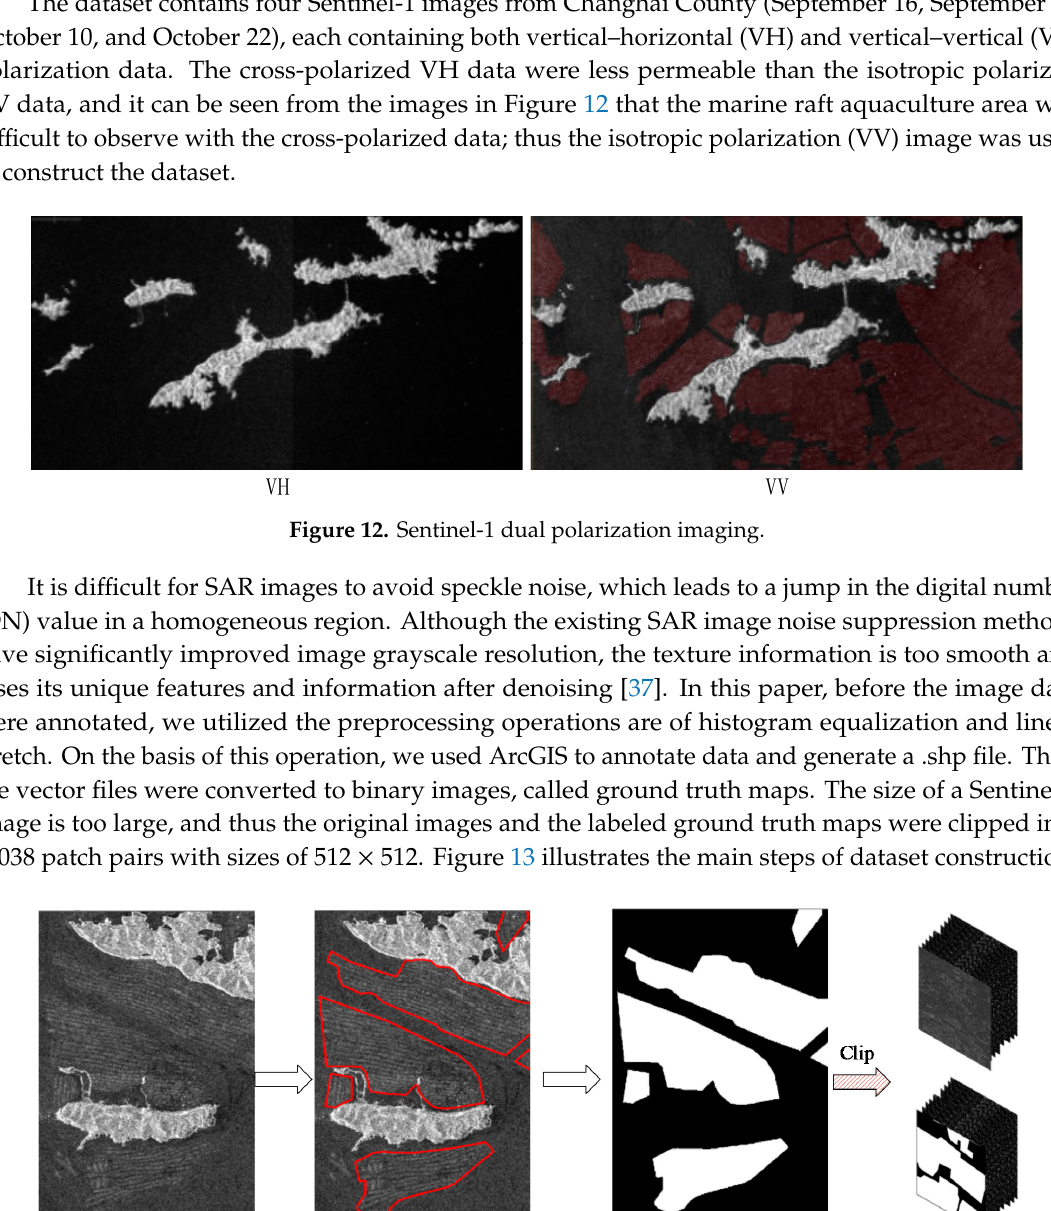
Figure 11. Study area.